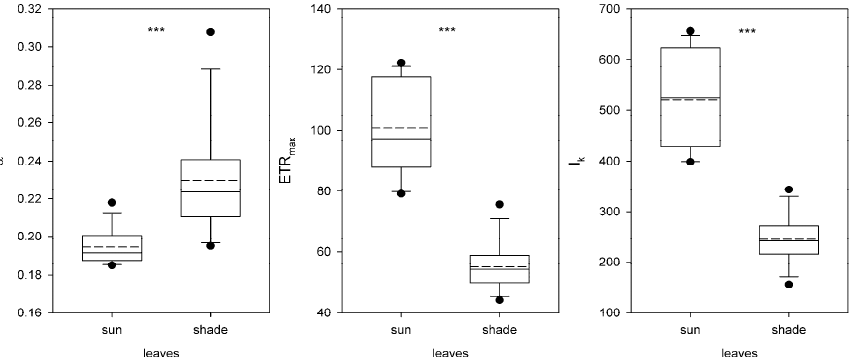
Figure 3. The maximum quantum yield for whole chain electron transport ( α ), the maximum electron transport capacity (ETR max ) and the theoretical light saturation intensity (I k ) for the sun and shade leaves of Phragmites australis in dense patches. Boxes encompass the 25% and 75% quartiles of all the data, the central solid and dashed lines represents the median and the average, bars extend to the 95% confidence limits, and dots represent outliers. For all bars n = 15. Differences were tested with the Mann-Whitney Rank Sum Test; *** indicates p < 0.001.